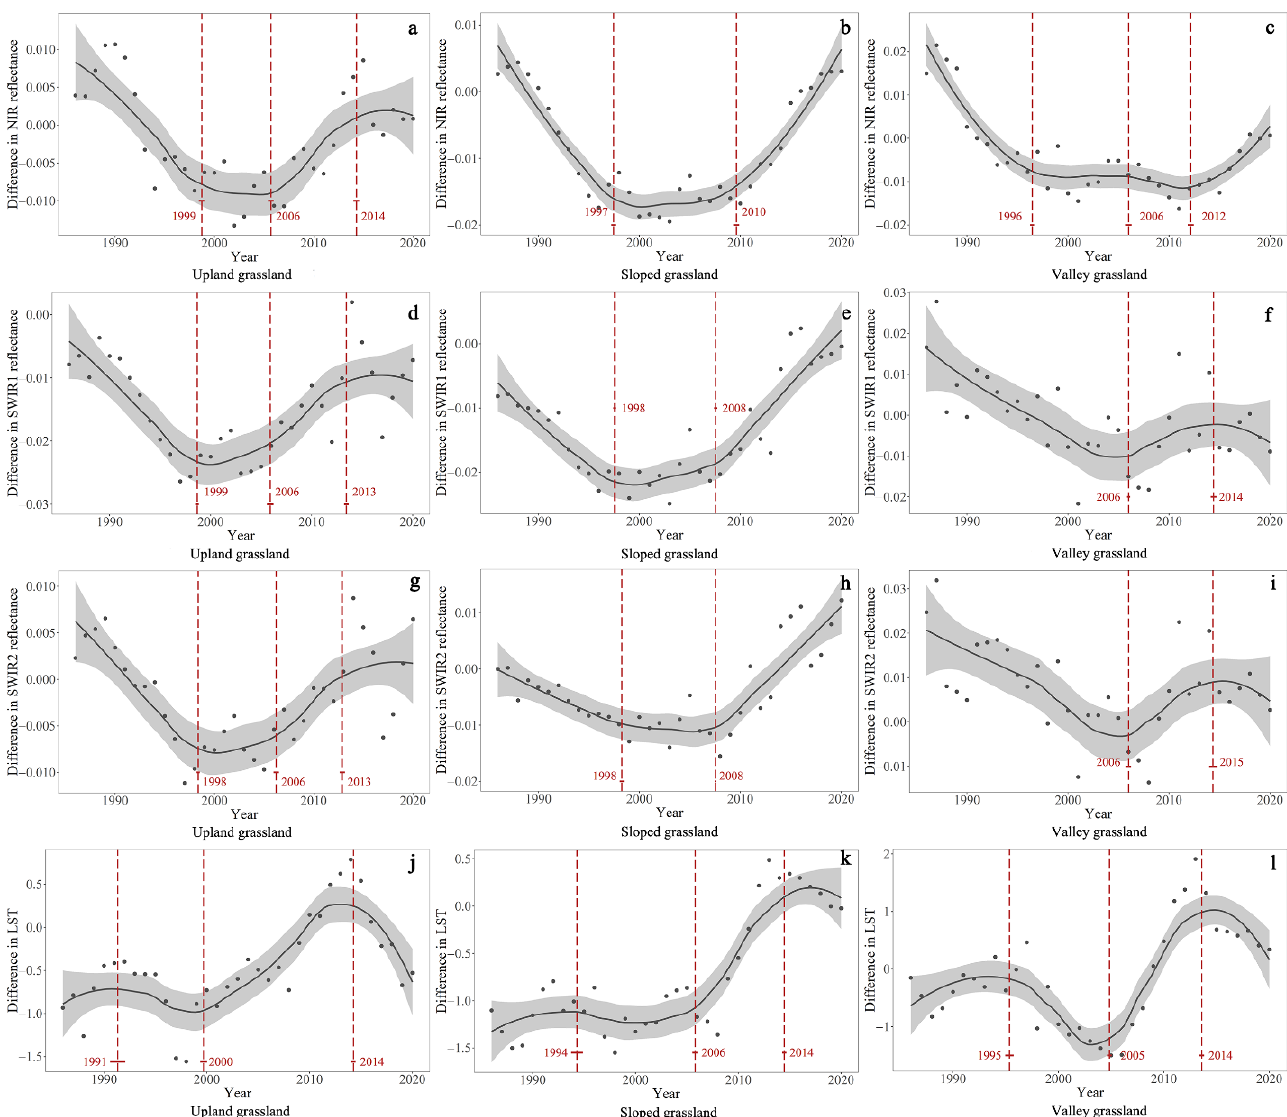
Figure 3. The temporal trends of the difference in near-infrared (NIR, first shortwave infrared (SWIR1), and second shortwave infrared (SWIR2) reflectance and land surface temperature (LST) between Grasslands National Park (GNP) sites and surrounding pastures: ( a ), ( b ), and ( c ) are the temporal trends of the differences in NIR reflectance for upland, sloped, and valley grasslands, respectively; ( d ), ( e ), and ( f ) are the temporal trends of the difference in SWIR1 reflectance for upland, sloped, and valley grasslands, respectively; ( g ), ( h ), and ( i ) are the temporal trends of the difference in SWIR2 reflectance for upland, sloped, and valley grasslands, respectively; ( j ), ( k ) ,and ( l ) are the temporal trends of the difference in LST for upland, sloped, and valley grasslands, respectively. Table 3. The effective period and intensity of grazing cessation and reintroduction on three native vegetation communi- ties.